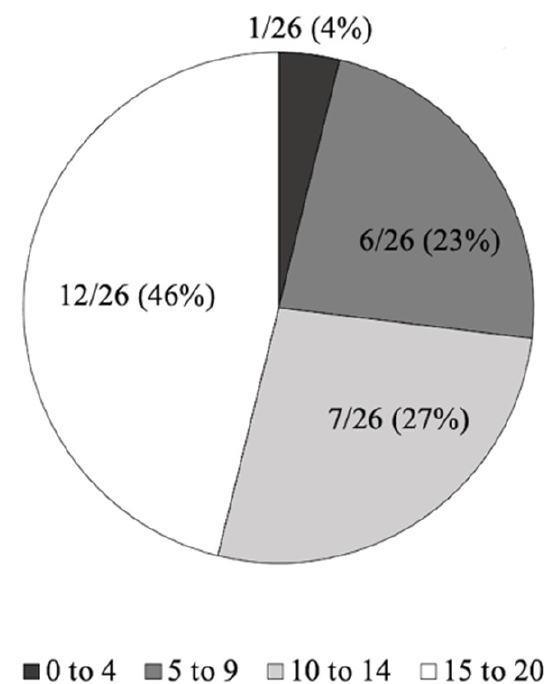
Figure 10. Number of records during the 10 first days of monitoring. Data in the pie charts represent the number of patients as n/N (%).